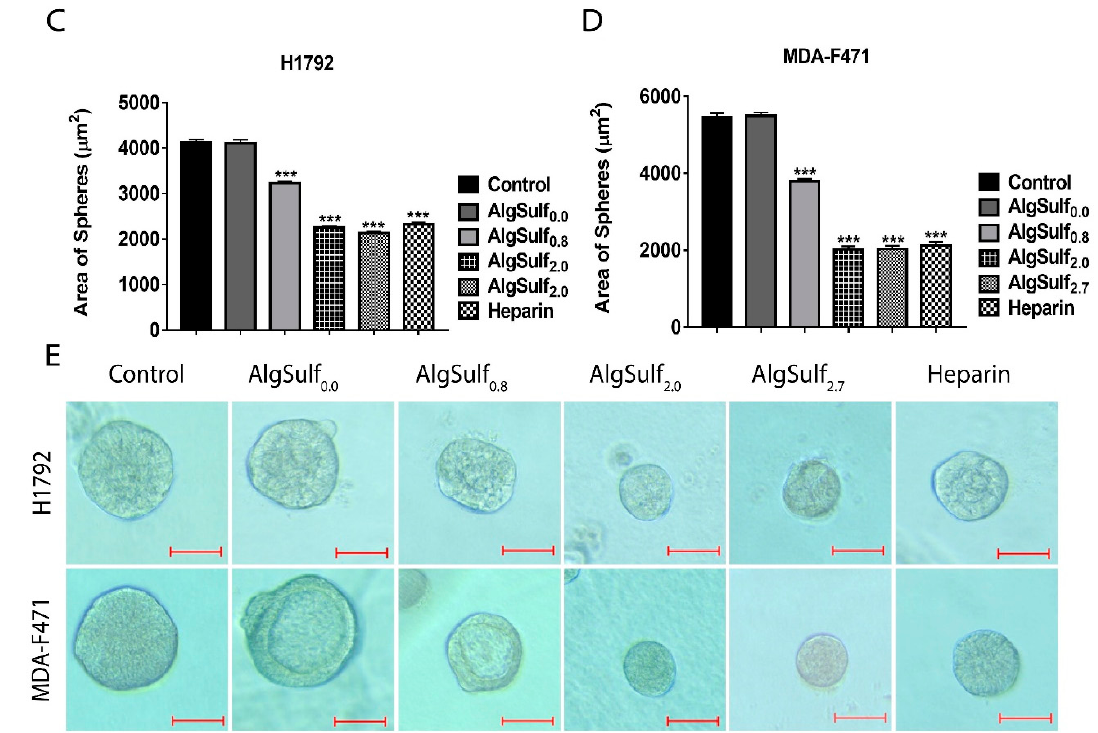
Figure 4. The e ff ect of the DS of biomimetic sulfated GAGs on the sphere-forming capacities of human and murine LUAD cell lines. ( A and B ) Quantification of the sphere-forming unit (SFU) for H1792 and MDA-F471 spheres at G2 under di ff erent treatment conditions. ( C and D ) Quantification of the average area ( µ m 2 ) of 30 spheres at G2. ( E ) Representative bright-field images of H1792 and MDA-F471 spheres at G2 with di ff erent DS of biomimetic GAGs. Data represent the average of three independent experiments and are reported as mean ± SEM (*** p < 0.001) using one-way ANOVA followed by Bonferroni’s multiple comparison test. Scale = 50 µm.